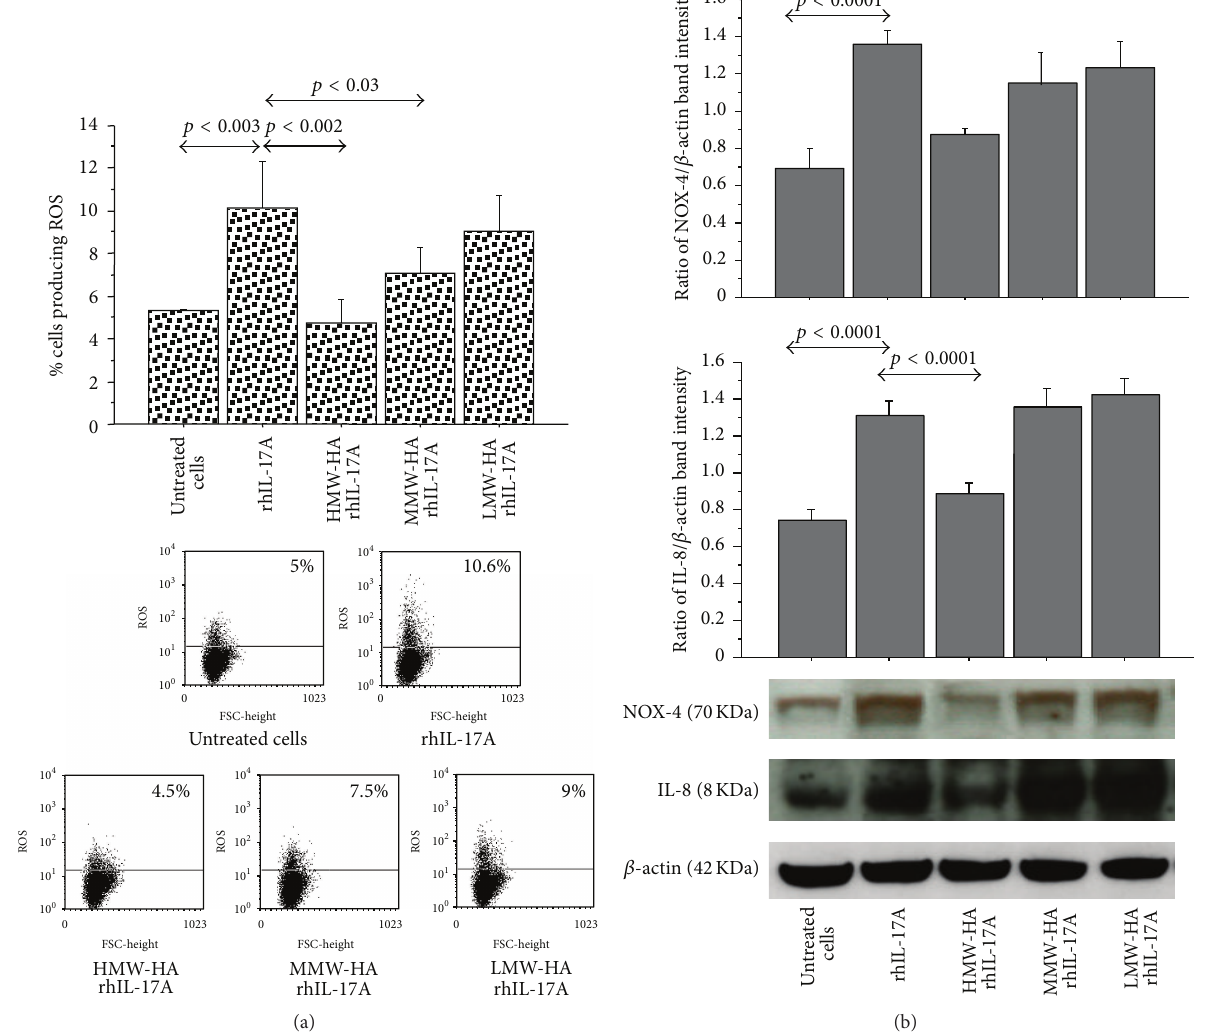
Figure 4: Effect of HMW-HA, MMW-HA, and LMW-HA in RPMI 2650 cells stimulated with rhIL-17A. (a) The cells were preincubated with HMW-HA (100 𝜇 g/mL), MMW-HA (100 𝜇 g/mL), and LMW-HA (100 𝜇 g/mL) for 1h and then stimulated with rhIL-17A (20 ng/mL) for 6 hrs. ROS production was evaluated in the cells by flow cytometry. The bars expressed mean ± SD of 3 separate experiments. Representative flow cytometry is shown; (b) the cells were preincubated with HMW-HA (100 𝜇 g/mL), MMW-HA (100 𝜇 g/mL), and LMW-HA (100 𝜇 g/mL) for 1h and then stimulated with rhIL-17A (20ng/mL) for 18hrs. NOX-4 and IL-8 protein synthesis were evaluated in the cell lysates by western blot. The bars represent the ratio of band intensity and 𝛽 -actin of 3 separate experiments. Representative western blot is shown. ANOVA with Fisher’s test correction was used for the analysis of the data. 𝑝 < 0.05 was statistically significant.